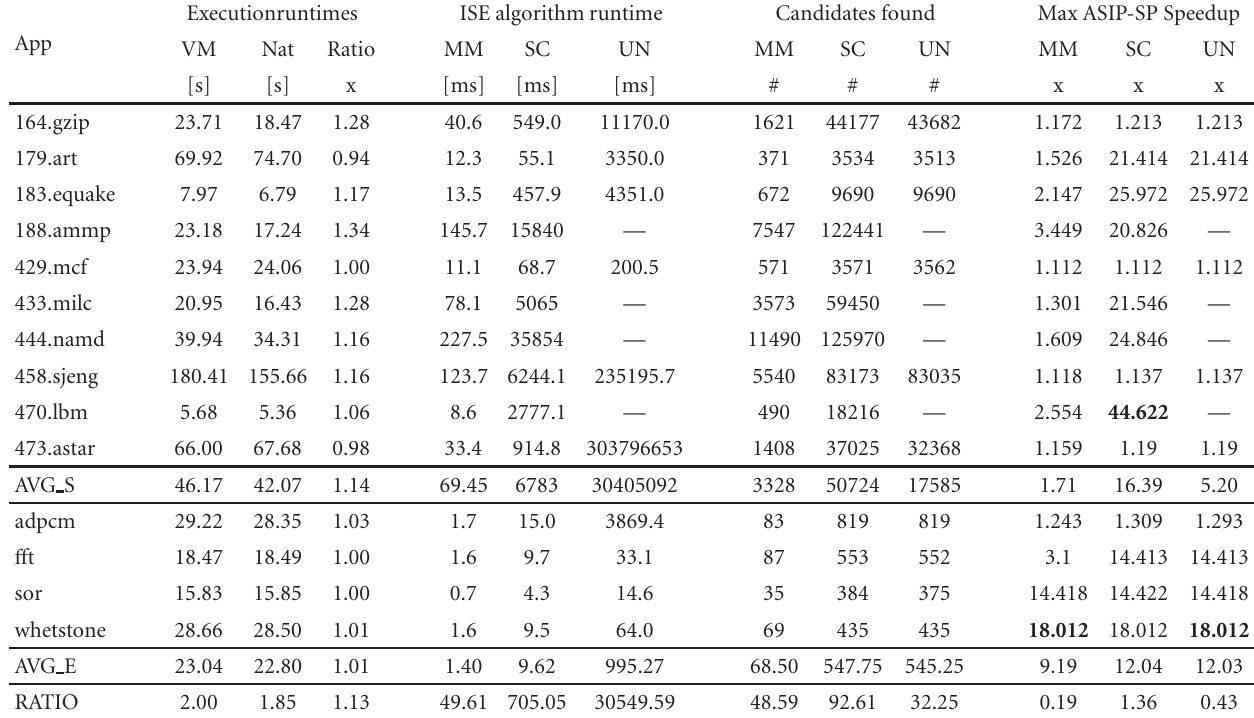
Table 5: Specialization process executed for whole applications when targeting the Woolcano architecture without capacity constraints. The performance of the custom instructions has been determined with the PivPav tool. ISE algorithms: MM: MaxMiso, SC: SingleCut, UN: Union. SC and UN search is constrained to 4 inputs and 1 input.